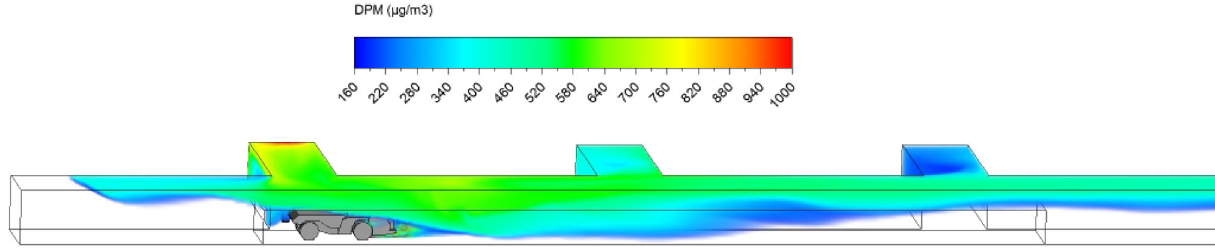
Fig. 15 DPM distributions in scenario 2 during the loading operation at 180